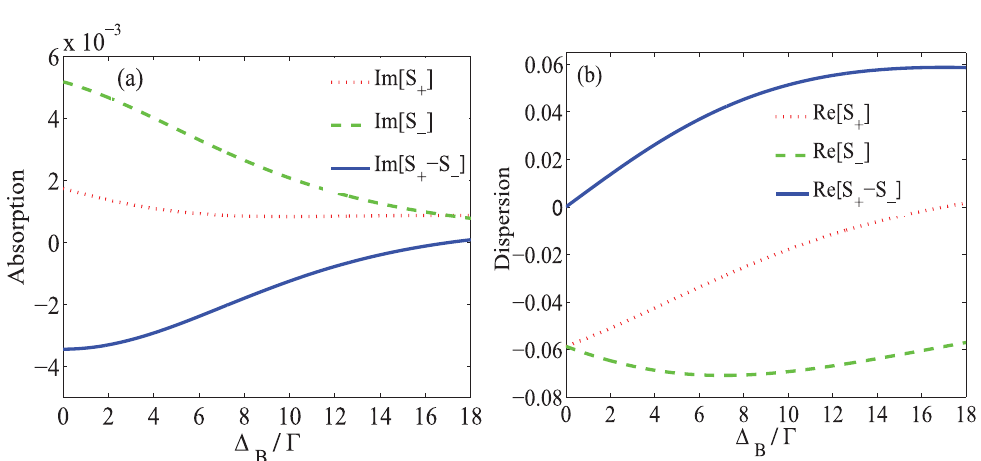
Figure 4. The imaginary ( a ) and real ( b ) parts of + S (dotted) and − S (dashed) and their difference (solid) versus Δ . The taken parameters are Ω = . Γ 0 01 B